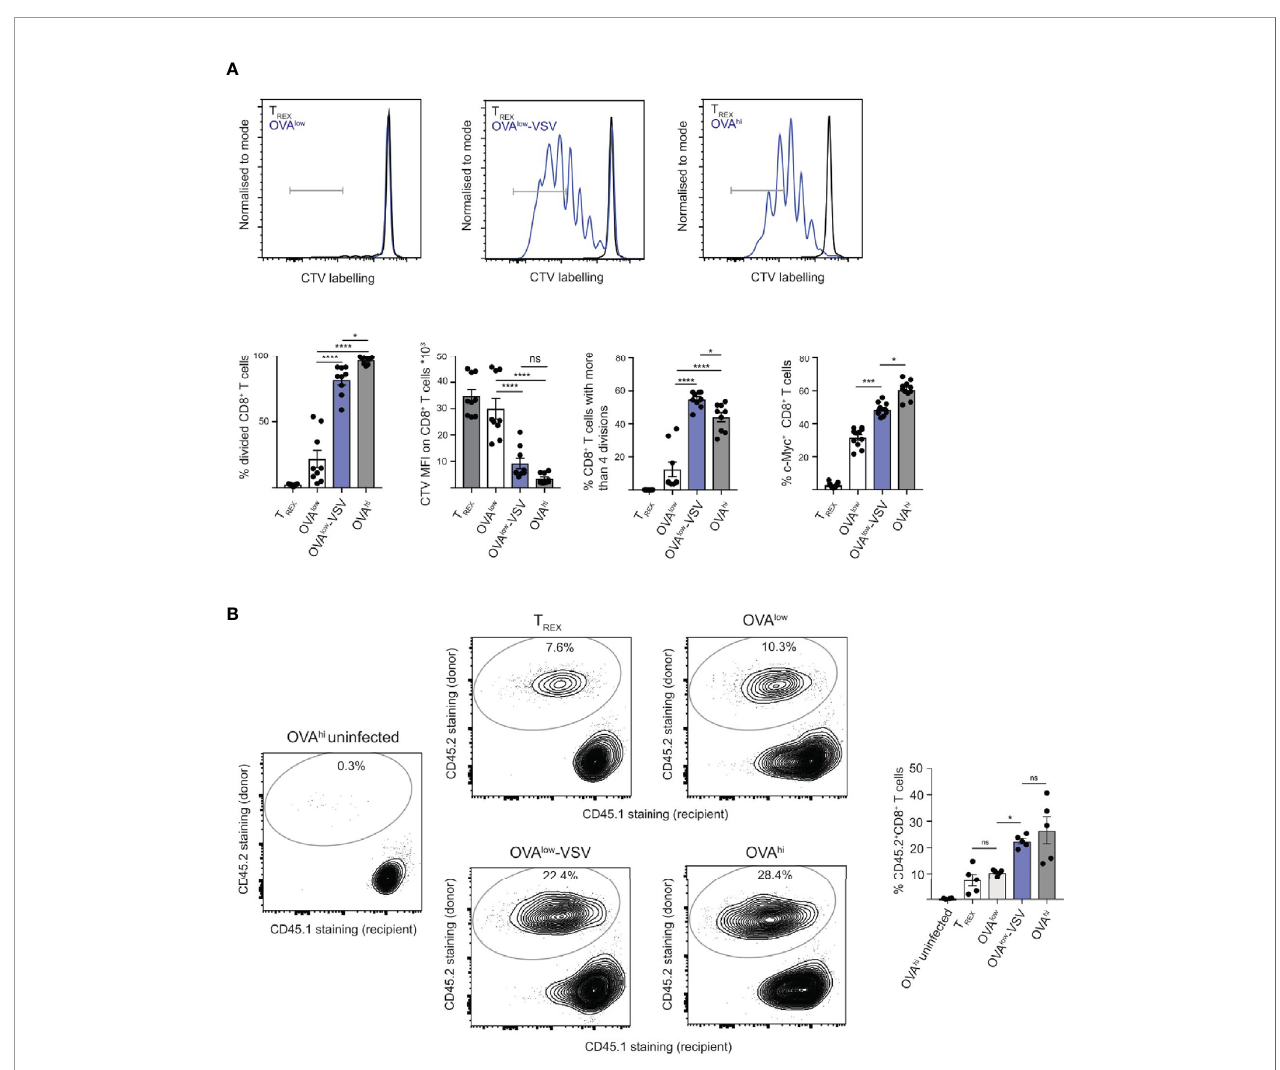
FIGURE 2 | Co-agonism enhances CD8 + T cell proliferation in vitro and in vivo . (A) Ex vivo OT-I lymphocytes were labelled with CTV and stimulated with the indicated CHO APCs for 4h, followed by transfer of T cells into wells without APCs, and proliferation analysis 3 days post-transfer. For c-Myc expression analysis, unlabeled OT-I cells were stimulated with the CHO APCs for 4h, followed by fi xation and staining. Data from 9 mice from 3 independent experiments, with representative fl ow cytometry fl ow plots shown. (B) Ex vivo OT-I lymphocytes (CD45.2 + ) were stimulated with the indicated CHO APCs for 4h, followed by adoptive transfer into CD45.1 + recipients. One day post-transfer, the recipient mice were infected with 10 4 cfu LM-OVA, and the expansion of the donor-derived CD45.2 + CD8 + T cells was analyzed 4 days post-infection. Flow cytometry plots show CD45.1 and CD45.2 staining on the CD8 + T cell population, representative of 2 independent experiments. Data